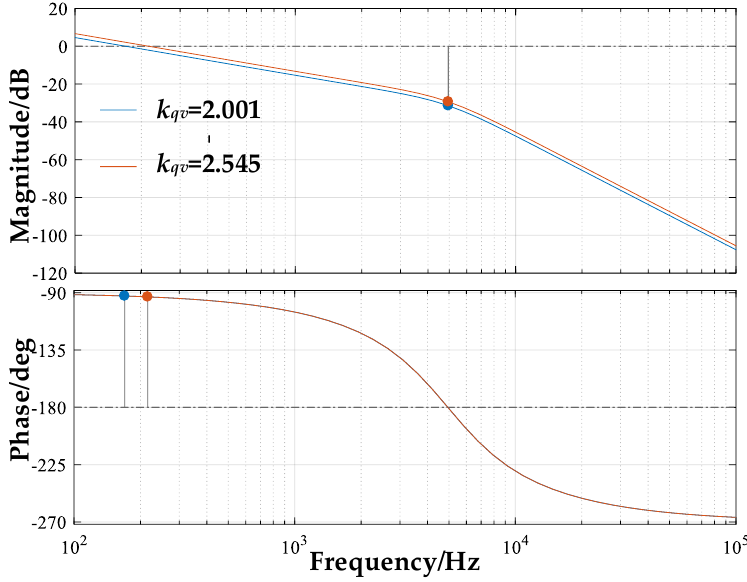
k qv =2.001 k qv =2.545